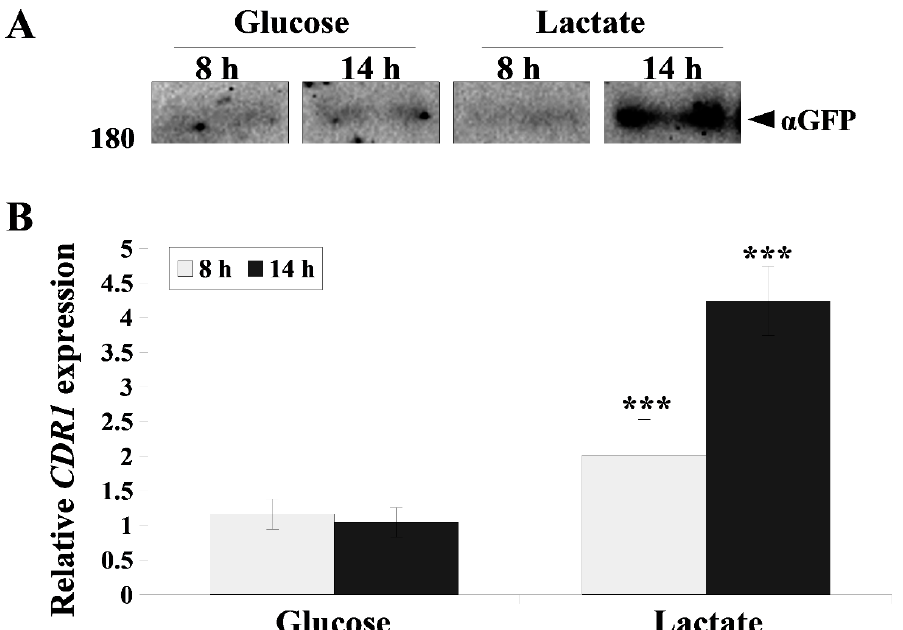
Figure 2. ( A ) Immunoblot analysis of Cdr1p levels in C. albicans ASCa1 ( CDR1-GFP ) strain during growth (8 and 14 h) in YPD (glucose) or YPL (lactate). The samples were resolved using 6% SDS-PAGE and probed with an anti- GFP antibody. Ponceau S staining was used as the loading control. The experiment was a representative of three independent assays, and the presented conditions were resolved in the same gel and cut out into separate lines (Figure S1 in Supplementary Materials). ( B ) Relative CDR1 gene expression in C. albicans during different growth phases (8 and 14 h) in YPD or YPL medium. Gene expression levels are represented as mean 2 −ΔΔ CT values ± SD ( n = 6) normalized to 1 for 8 h YPD-grown gene expression level. Statistical analysis compared YPD- and YPL-grown strains (*** p < 0.001).